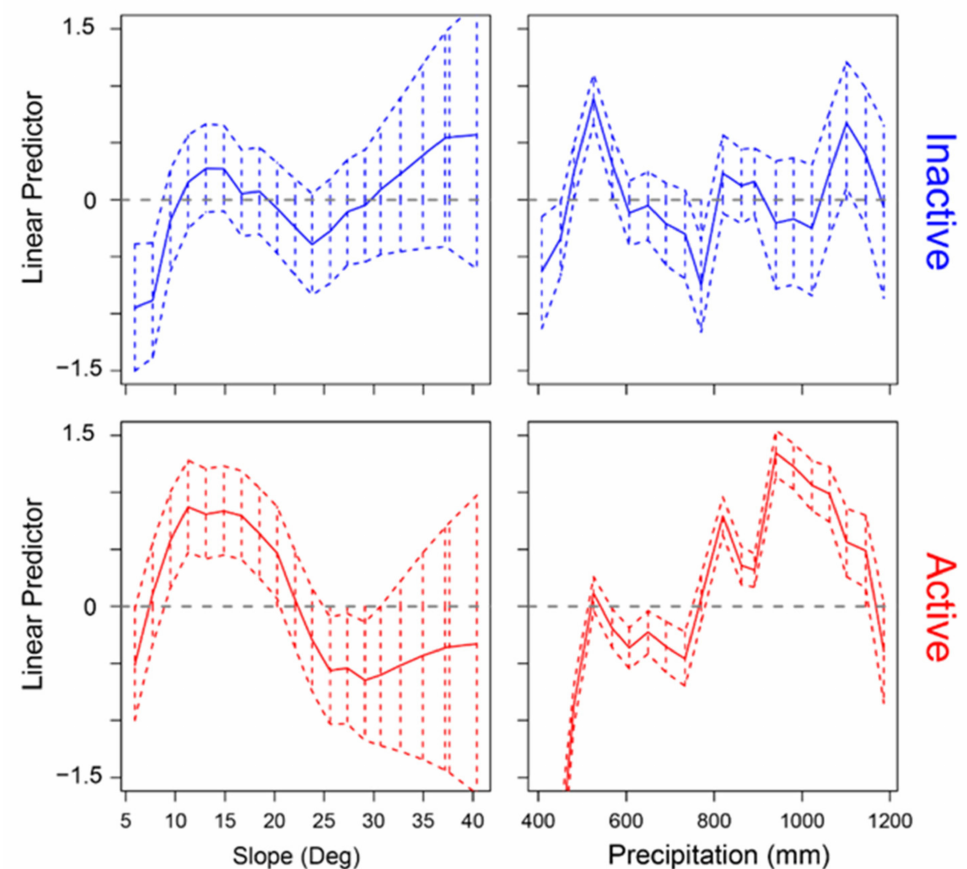
Figure 4. Nonlinear effects of slope ( left column) and precipitation ( right column) for inactive ( top row) and active ( bottom row) landslides. The effect is modelled as a random effect estimated over 20 classes with adjacent dependency. Thick coloured lines represent the posterior means whereas the coloured dashed lines indicate the posterior 95% credible interval. Dashed grey lines indicate the zero line along which coefficients play no role in the modelling